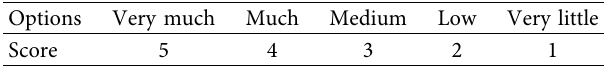
Table 6: Table of how to score each answer in the similarity of the system answer with the opinions of